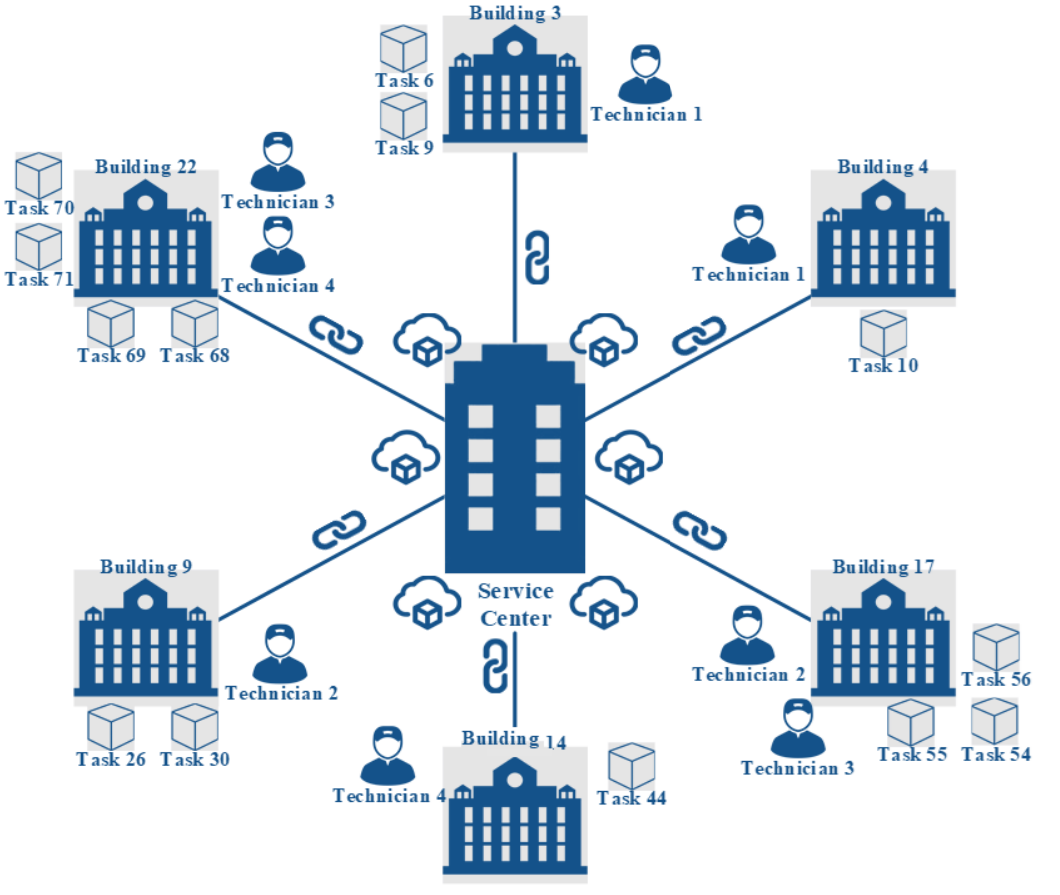
Figure 11. The planning process for service tasks by technicians in day 1. Table 9. The distribution of tasks for technicians in days 1 through